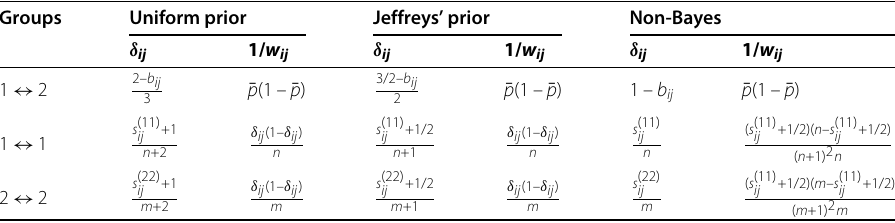
Table 1 Bifold Bernoulli methods: coefficient estimation formulas for the distances Groups Uniform prior Jeffreys’ prior Non-Bayes δ ij 1/ w ij δ ij 1/ w ij δ ij 1/ w ij 3/2– bij 1 ↔ 2 2– bij 3